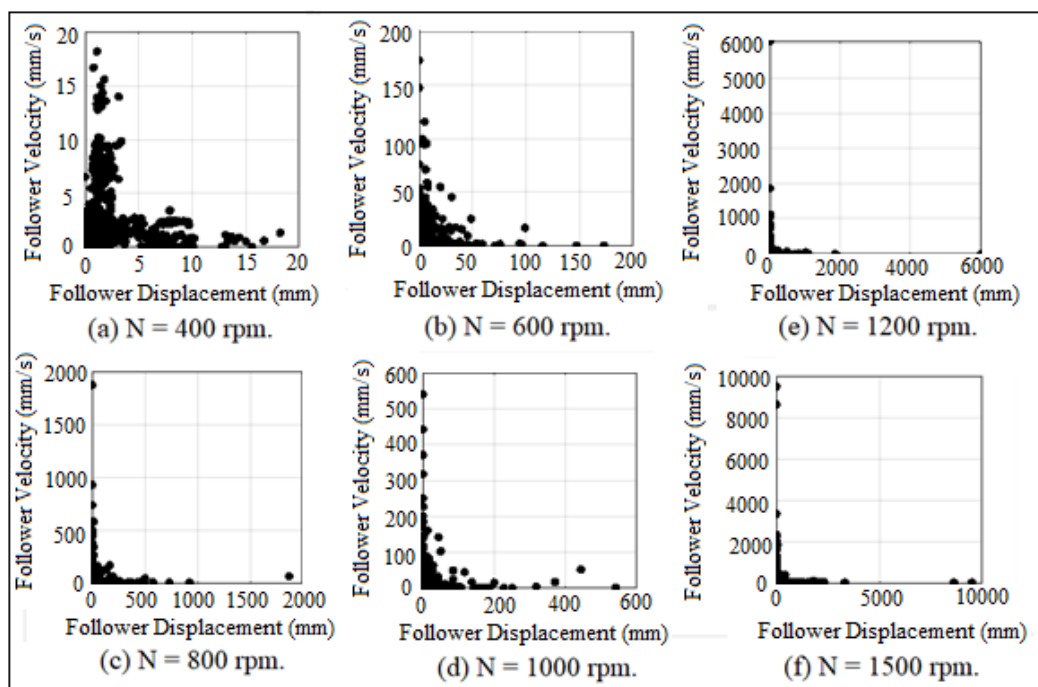
Figure 26. Poincare’ maps for (I.D. = 16 mm) at different cam speeds.